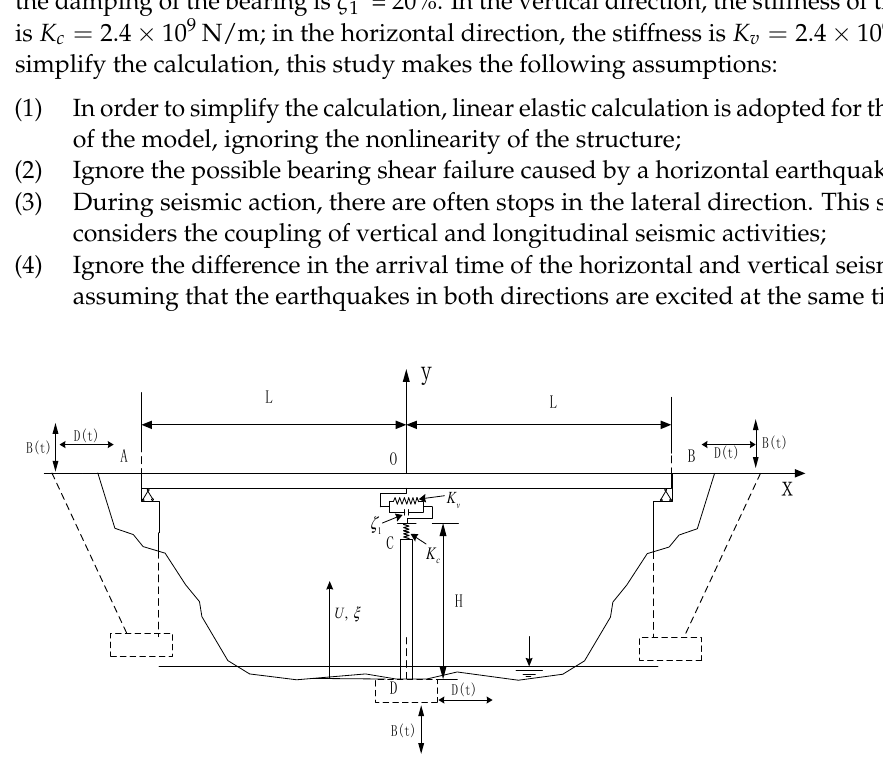
Figure 1. Model of a double-span continuous beam